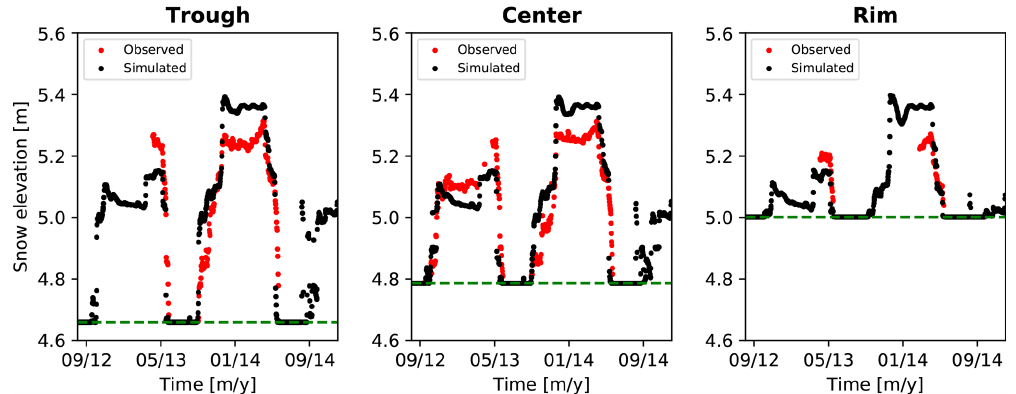
Figure 3. Observed and simulated snow elevation for the 2012–2013 and 2013–2014 winters at trough, center, and rim